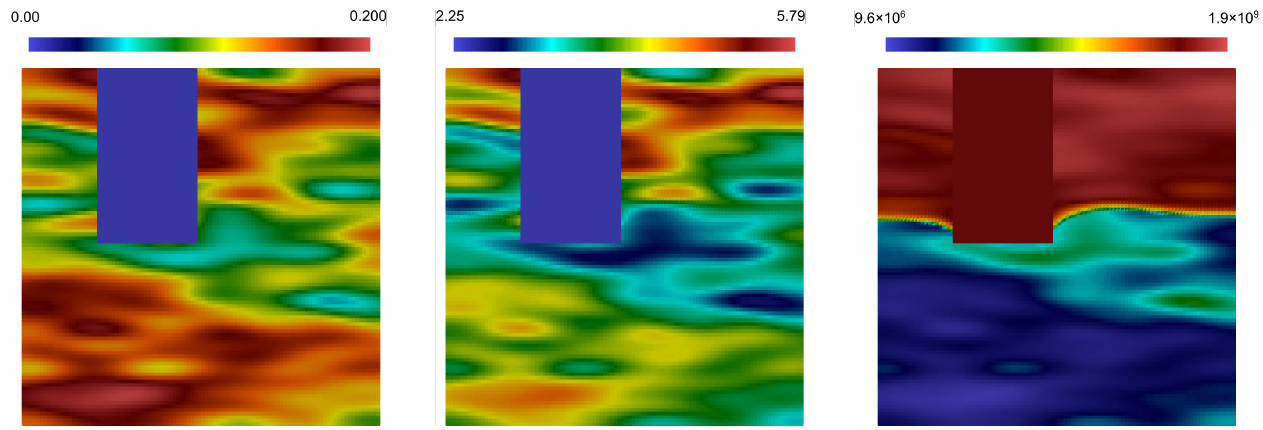
Figure 11. Distributions of φ , k , and E (from left to right) of the reference solution at the final